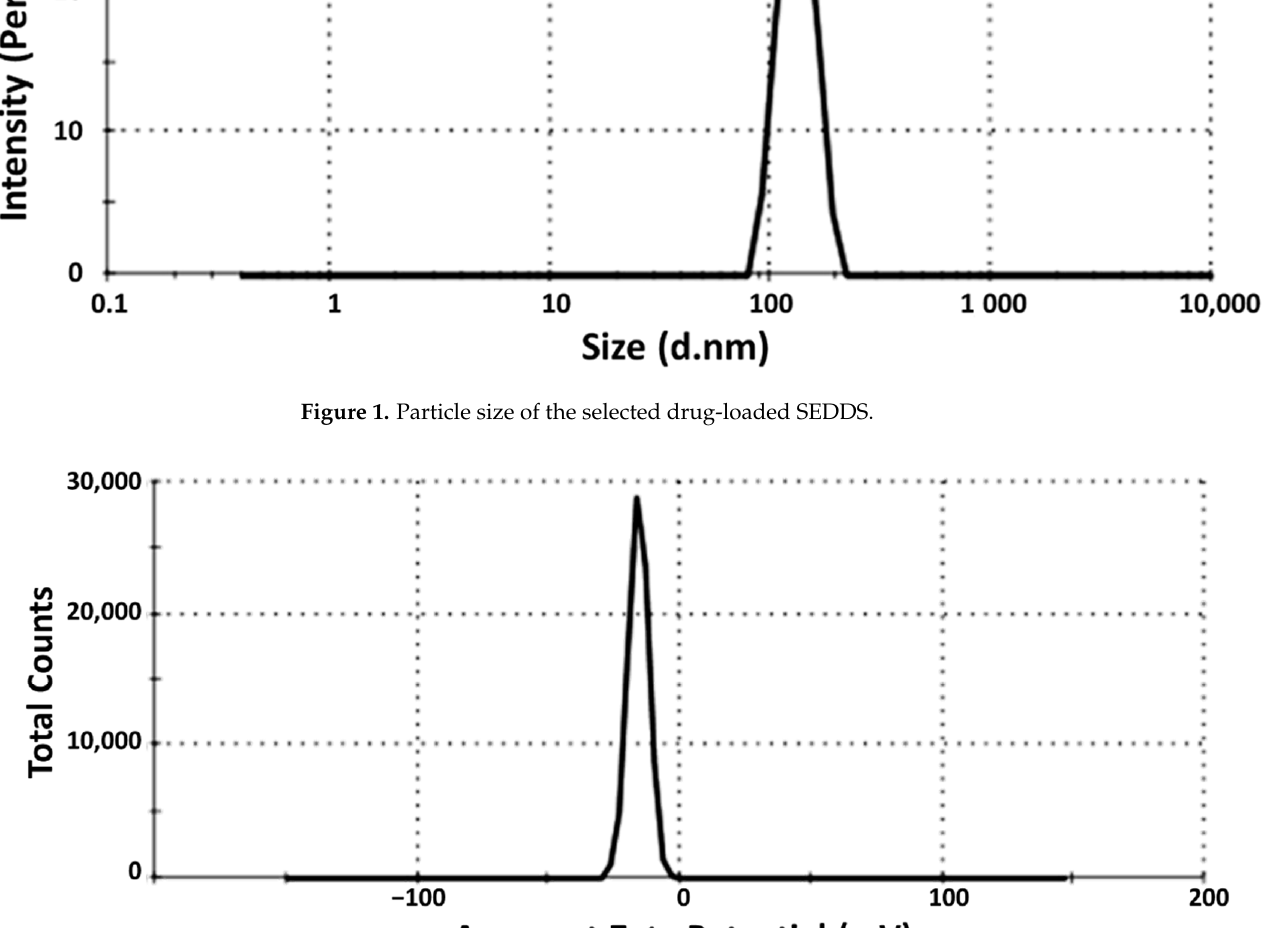
Figure 1. Particle size of the selected drug-loaded SEDDS.